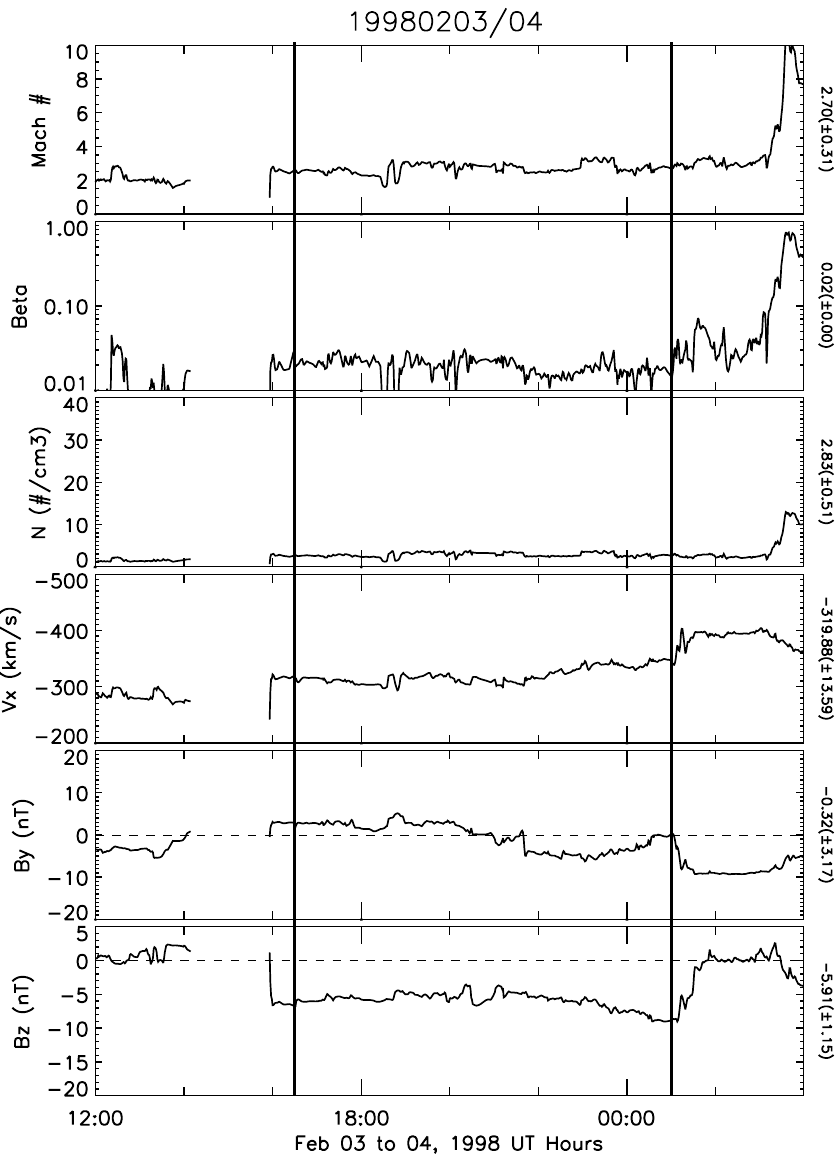
Fig. 3. A stack plot of solar wind/IMF parameters from the WIND satellite propagated to the magnetopause using the Weimer method for Event 1. Solar wind Alfv´en Mach Number. Solar wind plasma Beta. Solar wind Dynamic Pressure (nPa). Solar wind Vx (km/s) IMF By (nT) IMF B z (nT). Once again, the vertical lines represent the beginning and ending of the BRI. The numbers on the side are the averages and standard deviations for the BRI time frame only.